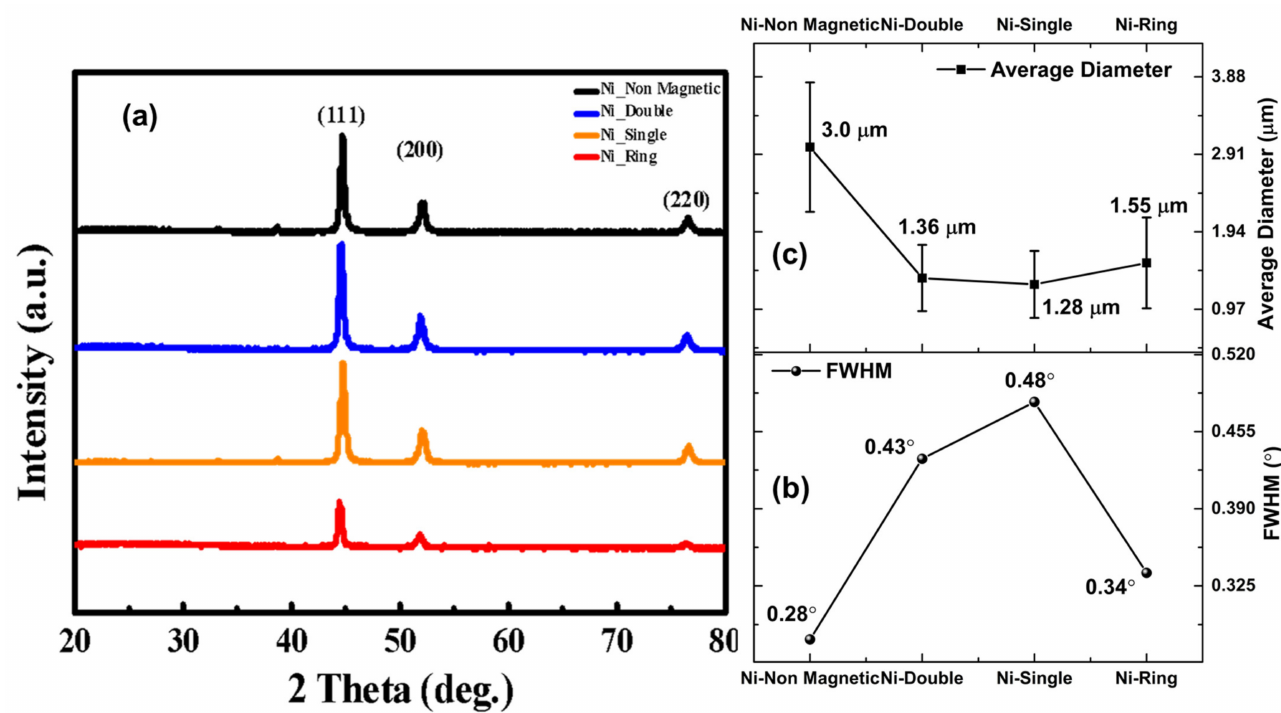
Figure 2. ( a ) XRD patterns of Ni-Non-Magnetic, Ni-Double, Ni-Single and Ni-Ring; ( b ) the values of FWHM calculated from XRD patterns; and ( c ) the average diameters of the Ni-wires. Error bar shows the standard